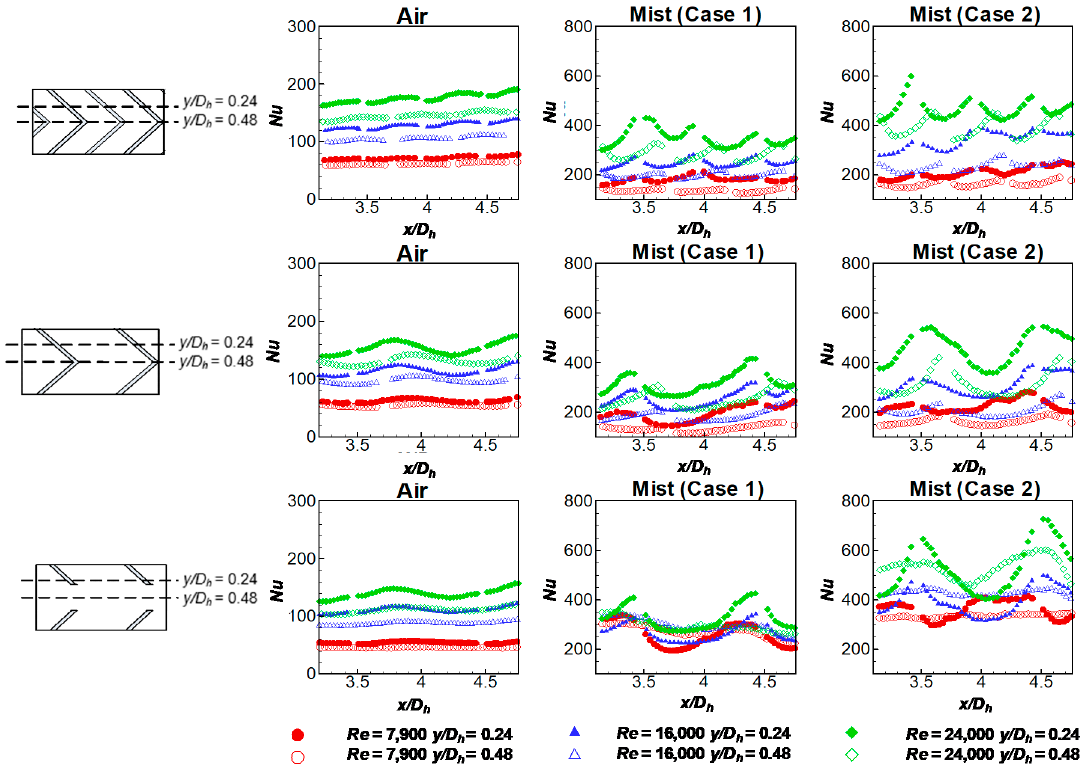
Figure 10. Streamwise Nusselt number distribution.